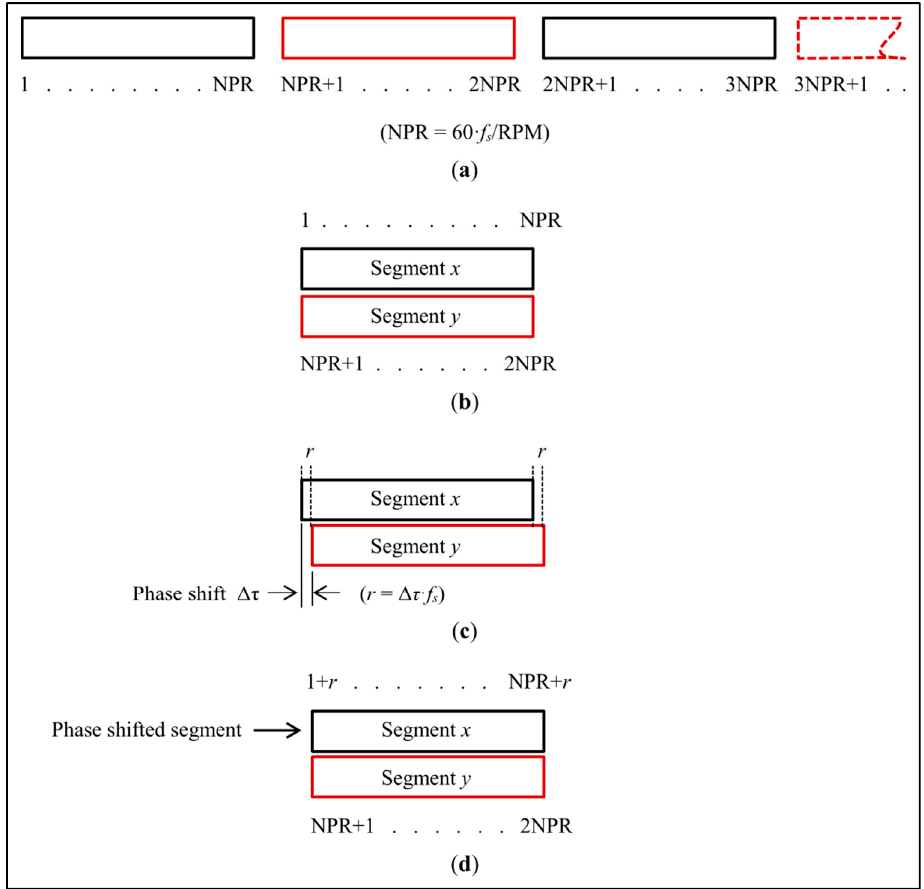
Figure 1. Schematics of phase shift detection between two consecutive raw data segments and phase adjustment process. ( a ) Divide raw acoustic data into uniform segments each having NPR (number of samples per revolution) samples; ( b ) Take two consecutive segments x and y and perform cross-correlation operation to find Δτ ; ( c ) Diagram shows y leading x by Δτ ; convert Δτ into number of samples r to phase-adjust x (or y ); ( d ) Realign or phase-adjust segments x and y according to r (i.e., Δτ ).